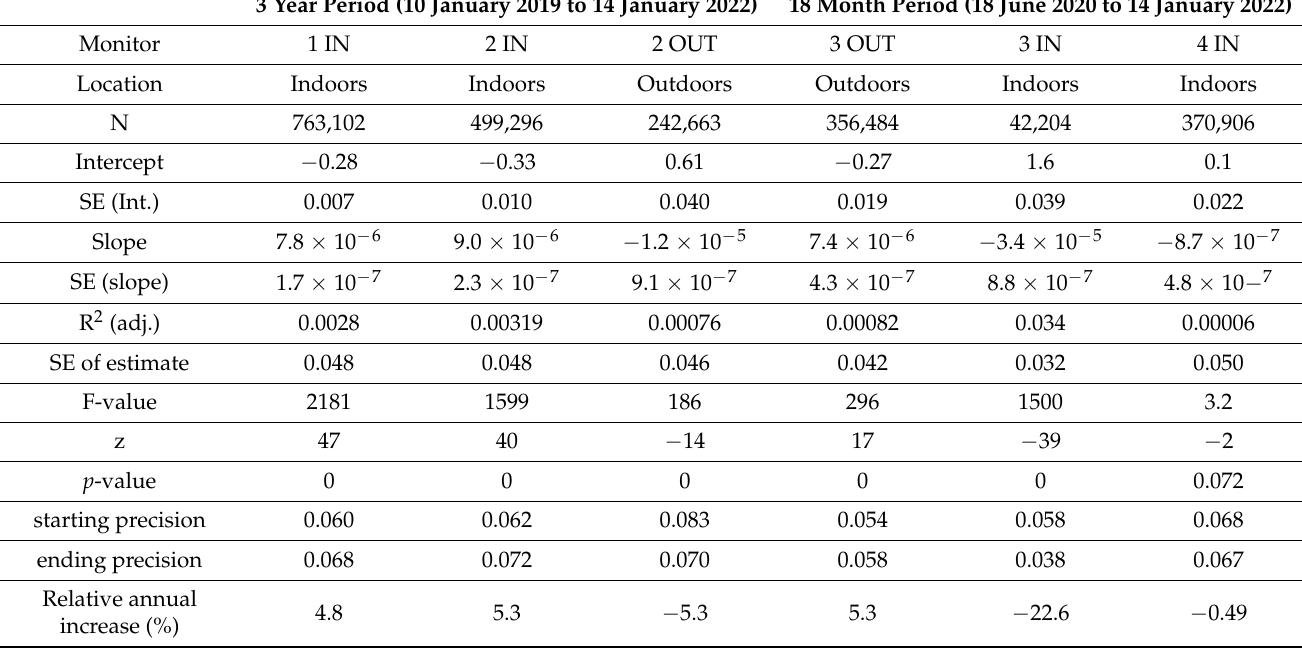
Table 3. Variation of precision over time for monitors 1 and 2 (3 years) and 3 and 4 (18